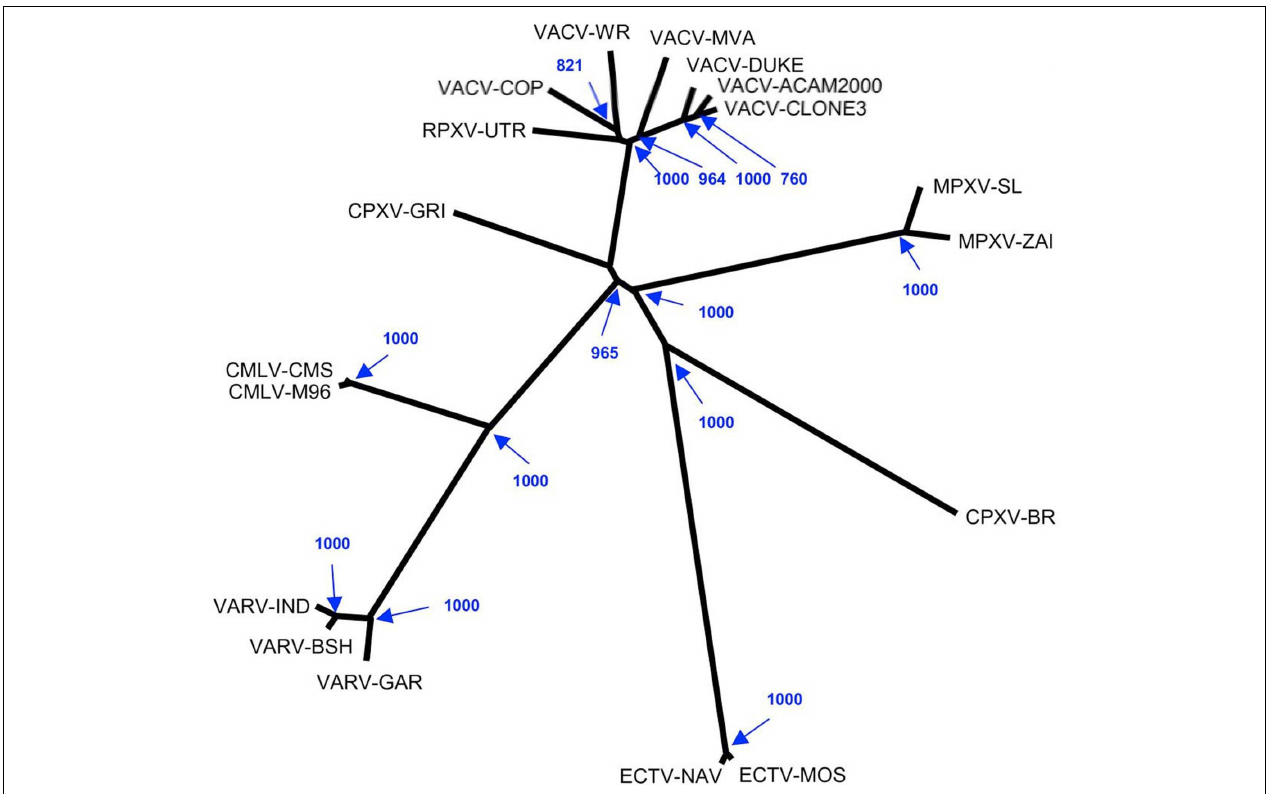
FIGURE 2 | Phylogenetic tree of the orthopox viruses. The tree was generated using an 82kb DNA sequence conserved among all fully sequenced orthopox viruses. Sampling number for bootstrap is 1,000; only bootstrap values above 500 are shown (from Guiyun et al.,